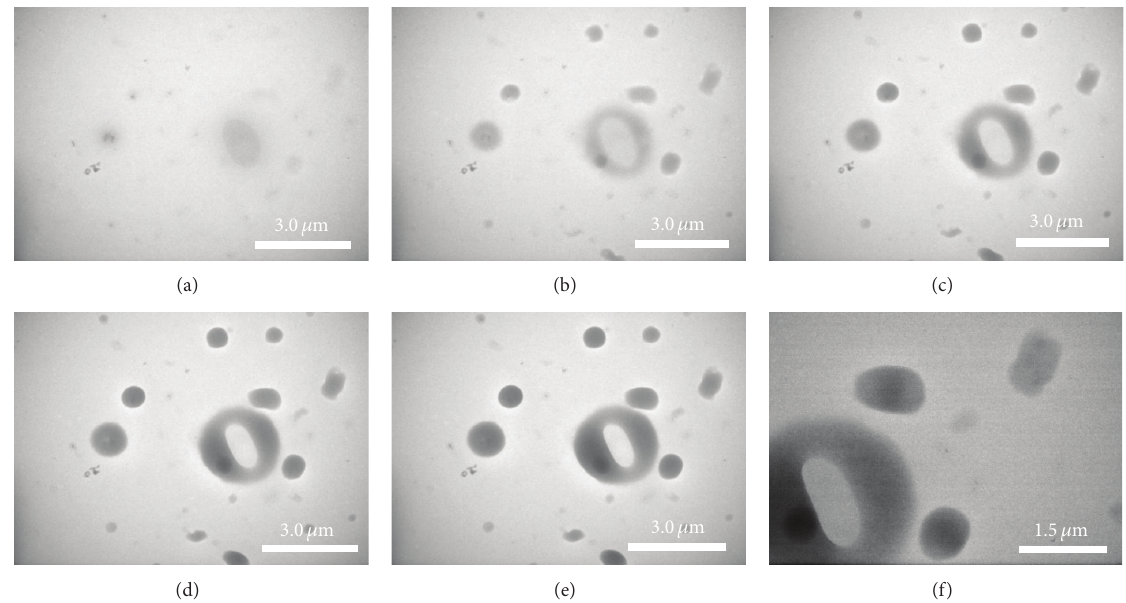
Figure 4: TEM images showing the process of cell damage: (a–e) show the outer ring of the oval-shaped E. coli cell becoming gray and surrounding gray dots appeared. (f) A magnified image taken after